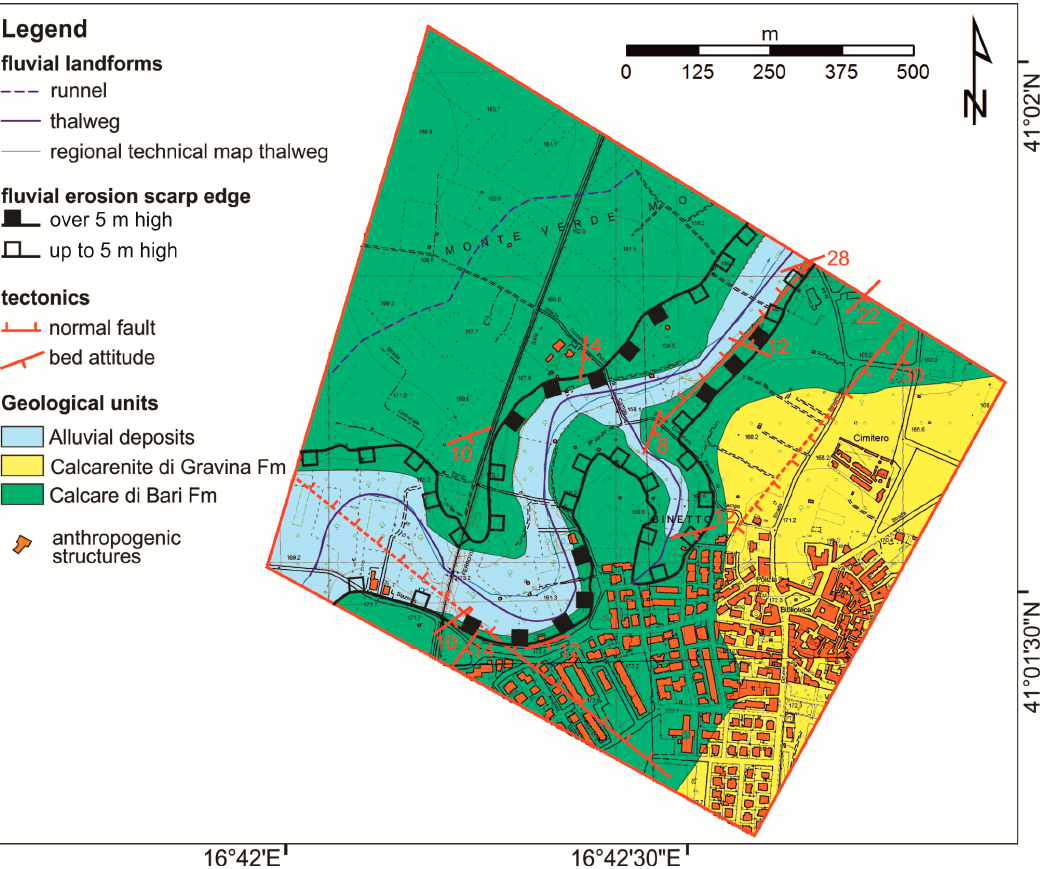
Figure 5. Geological and geomorphological field map of the study area.